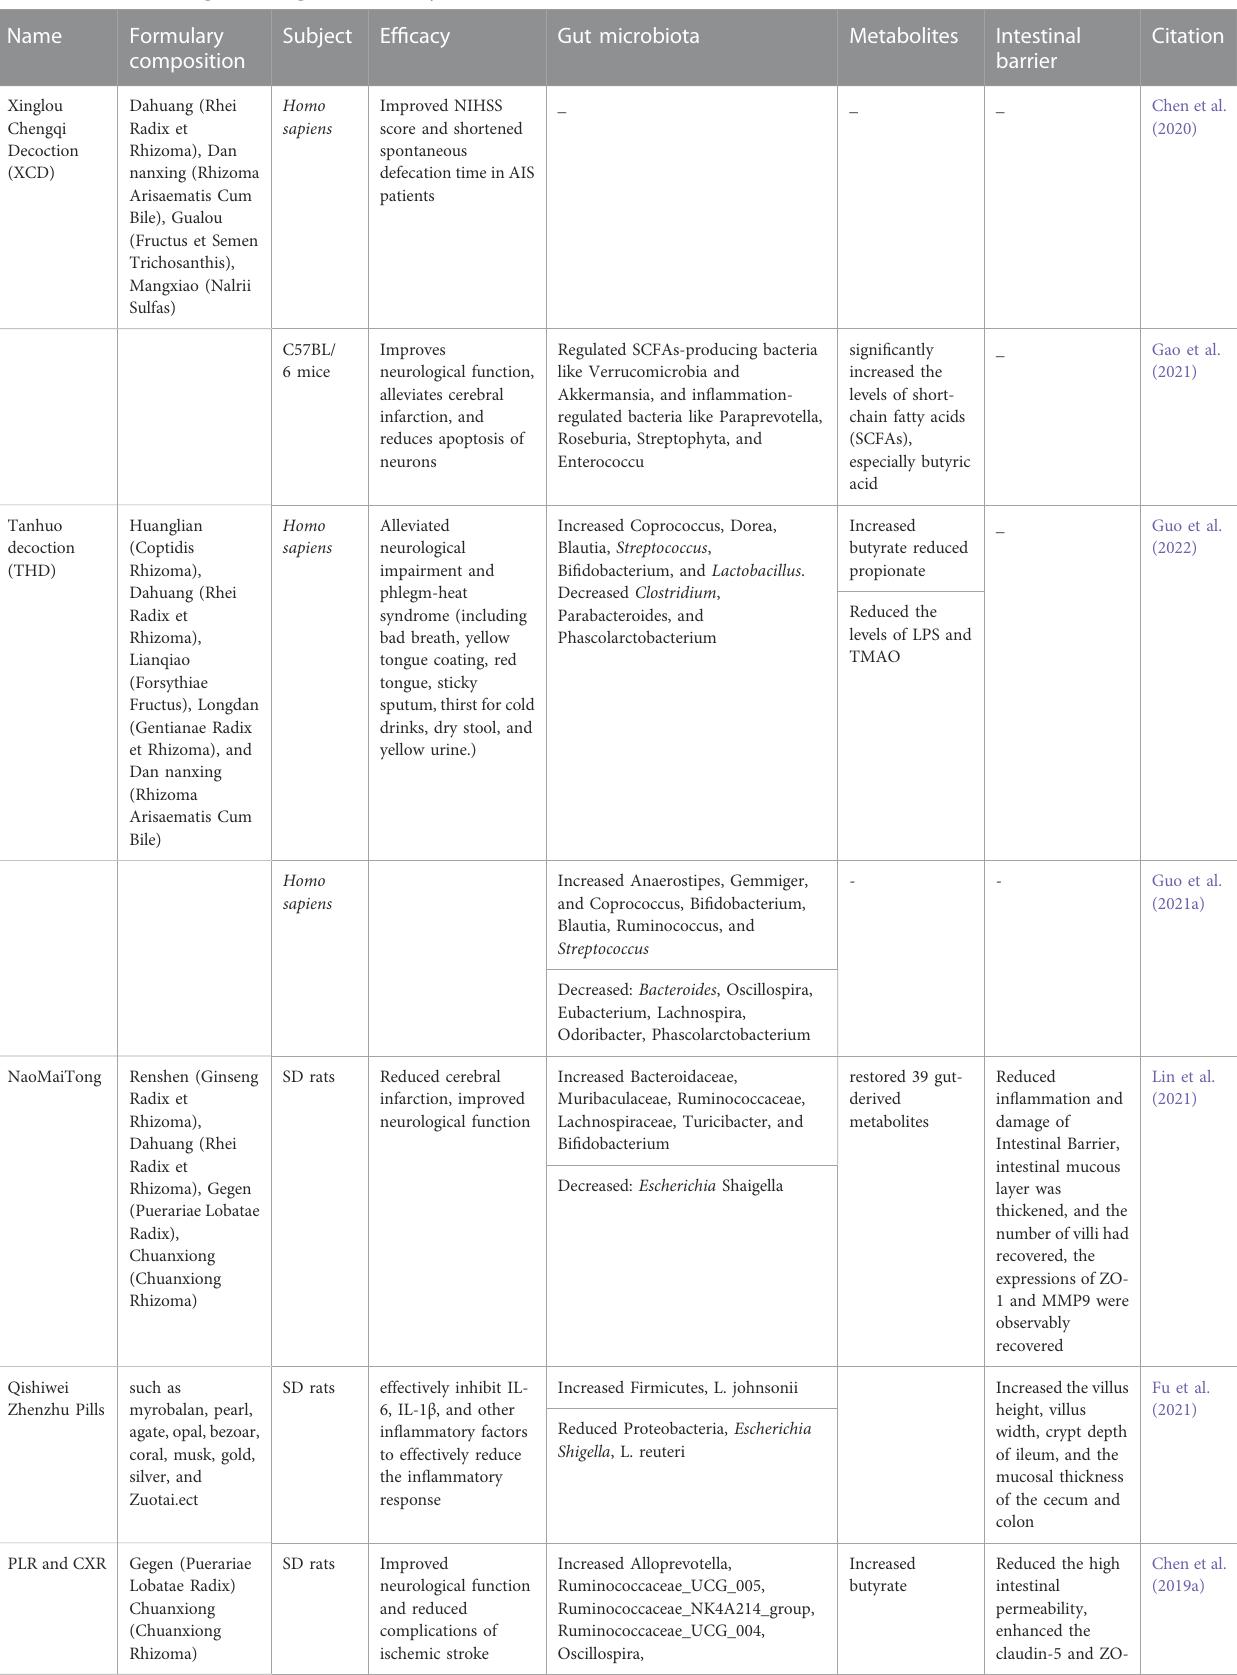
TABLE 1 Studies on the regulation of gut microbiota by Chinese herbal